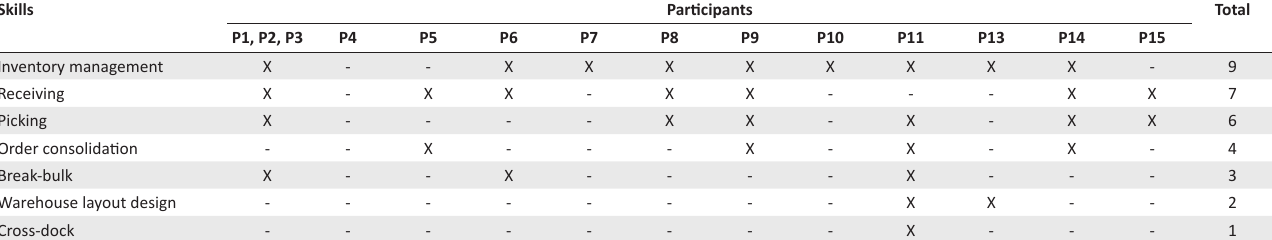
FIGURE 1: A summary of research questions and their related themes. TABLE 5: The industry’s expectations concerning warehouse management